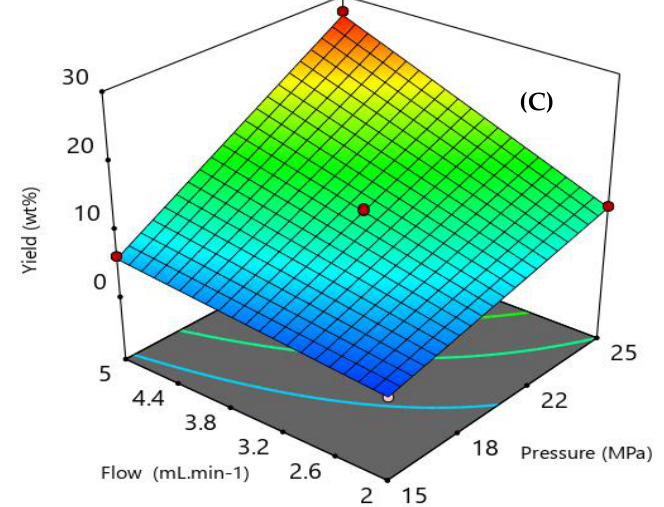
Figure 2. Response surface showing the behavior of the extraction yield as a function of ( A ) temperature and pressure with constant solvent flow rate of 3.5 g.min − 1 ; ( B ) temperature and solvent flow rate with constant pressure of 20 MPa; and ( C ) pressure and solvent flow rate with constant temperature of 318.15 K.